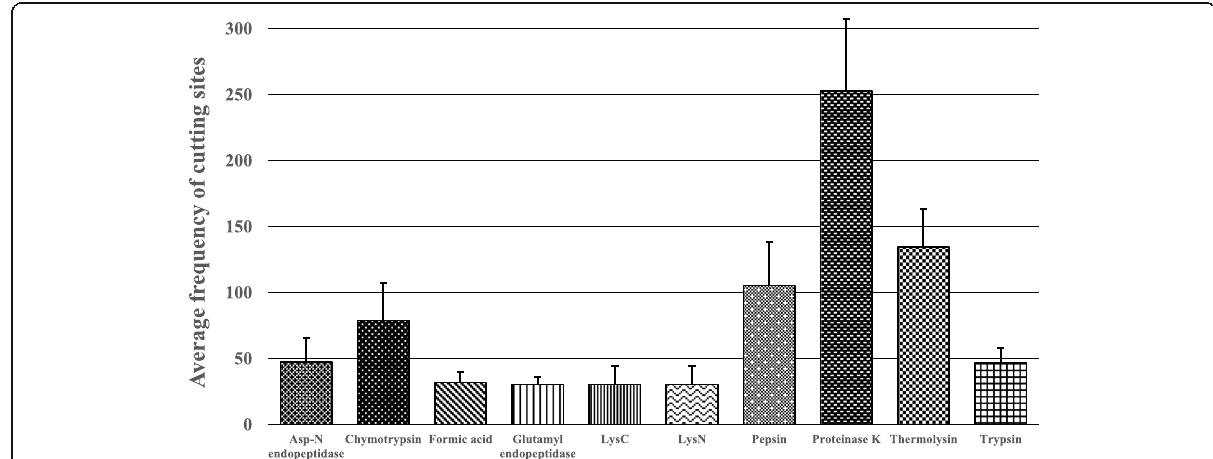
Fig. 7 Average number of cleavage sites for the GH5-cellulase family from uncultured microorganisms as identified through the peptide cutter